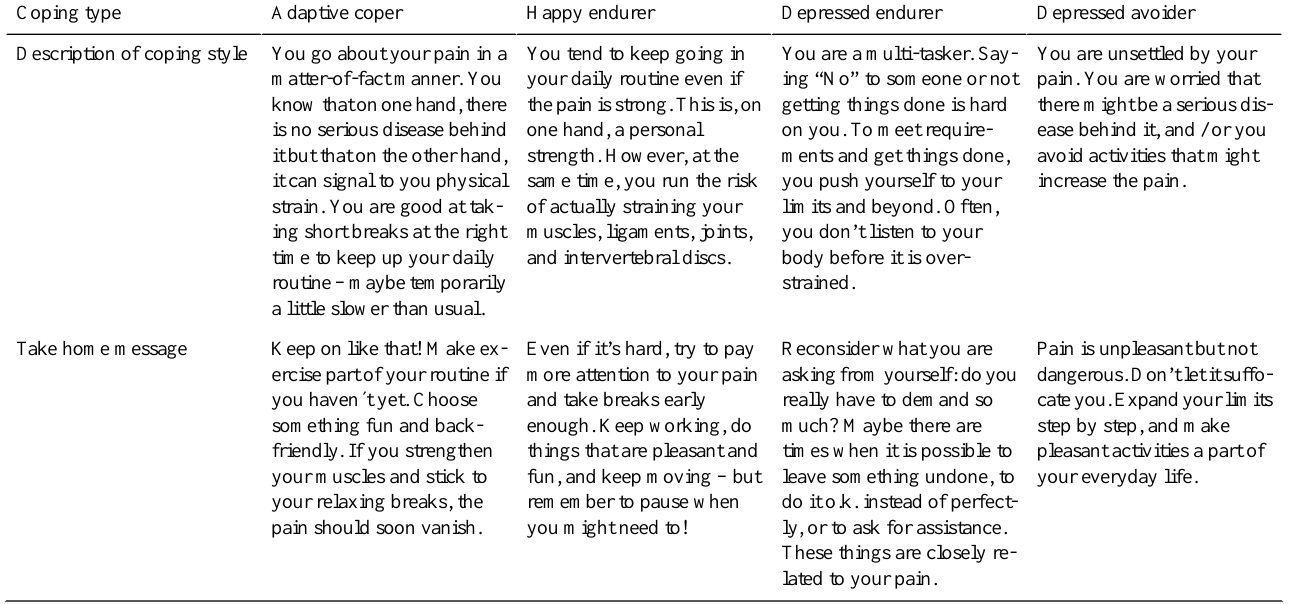
Table 3. Example of tailoring to coping style